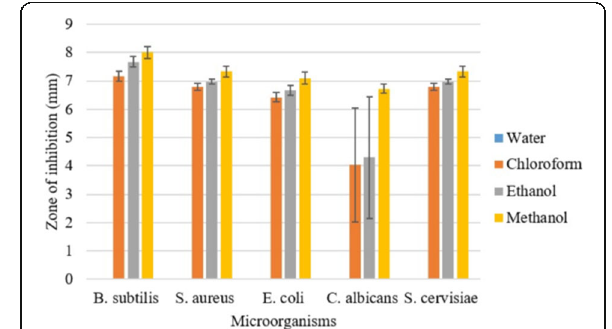
Fig. 3 Antimicrobial activity of negative